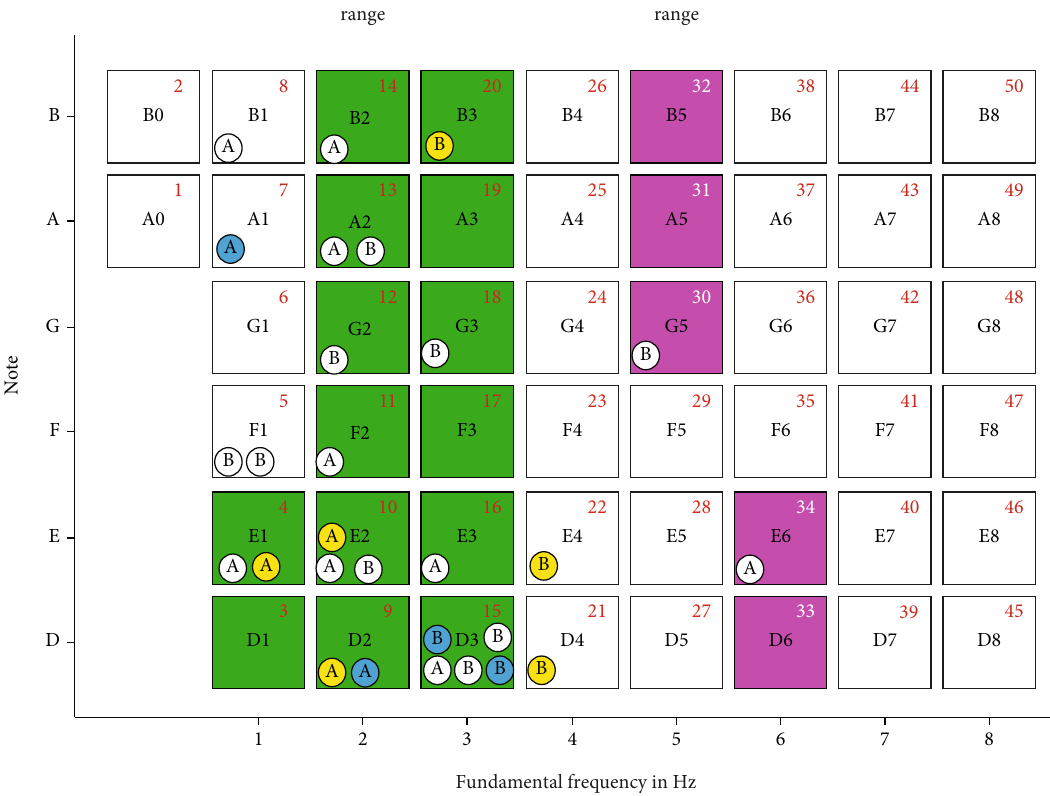
Figure 10: NW-NH. The balloons with the letter (A) represent mean results before the fatigue test, balloons with letter (B) represent mean results after the fatigue test, and the colors indicate the degree of signi fi cance; white balloons are not signi fi cant, blue were mildly signi fi cant, and yellow balloons were signi fi